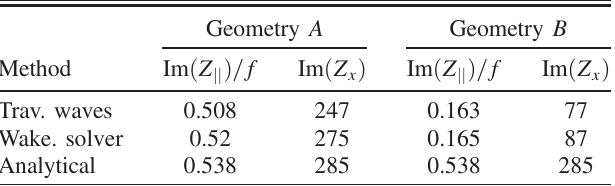
TABLE V. Comparison between the analytical model and the computational methods for two different geometries. The values for Im ð Z jj Þ =f are in Ω = GHz, and the values for Im ð Z Ω = m.